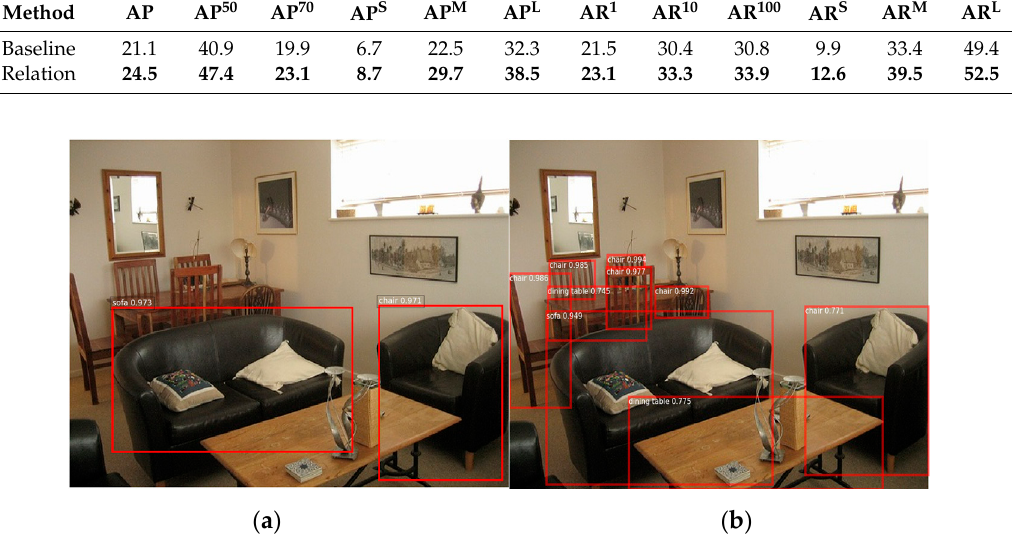
Figure 8. The detection results with relation information or without relation information. ( a ): without relation information. ( b ): with relation information. Table 7. Ablation study on PASCAL VOC 2007 test. All methods are trained on PASCAL VOC 2007trainval + 2012trainval. Baseline: Faster R-CNN. Relation: only using object-object relationships. The bold characters represent the best result for each column.